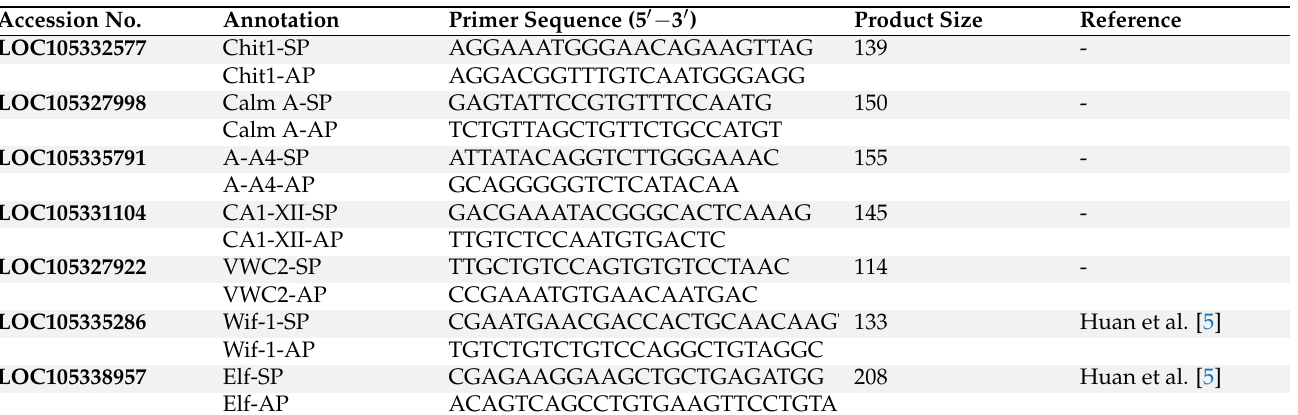
Table 1. Primers of selected genes used for qPCR verification.